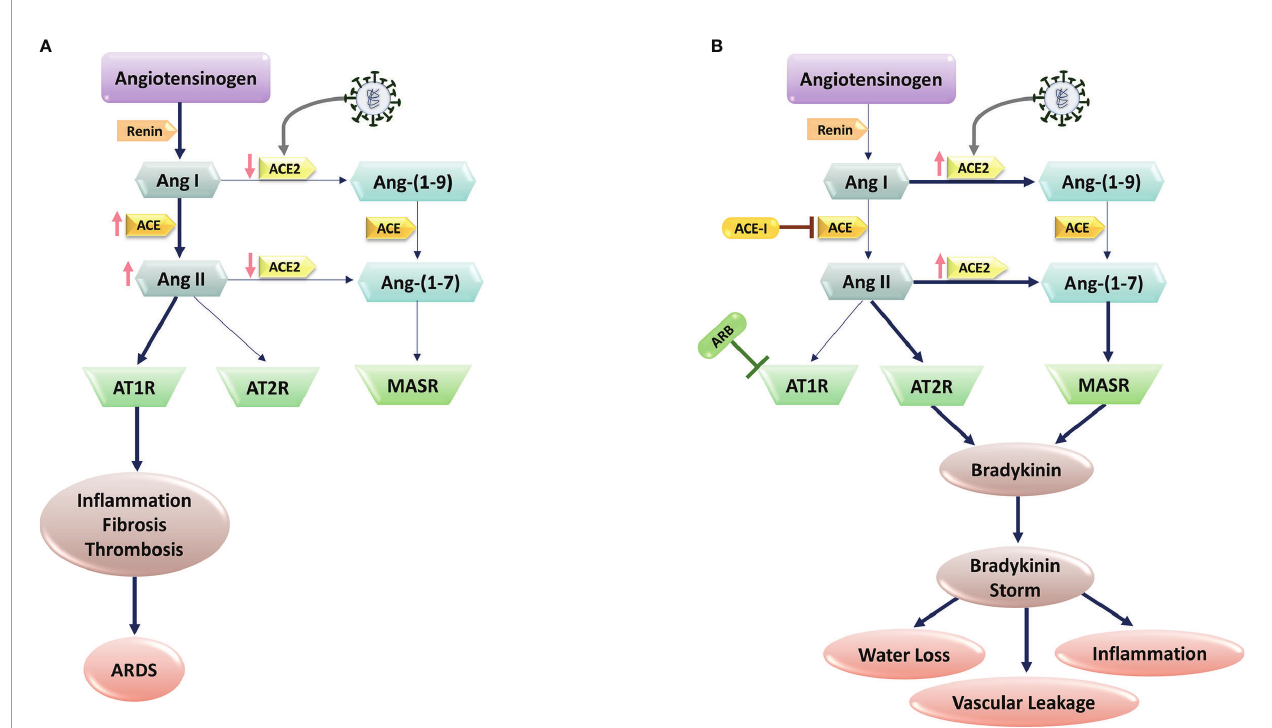
FIGURE 1 | SARS-CoV-2 and Renin-Angiotensin System (RAS) interactions. (A) SARS-CoV-2 infection is mediated via the human Angiotensin-Converting Enzyme 2 (ACE2), which would cause ACE2 downregulation. Subsequent block of Ang II/Ang – (1-7) metabolism lead to the high levels of Ang II production through ACE upregulation. The imbalanced Ang II/Ang 1 – 7 causes the suppression of AT2 and Mas receptors with anti-in fl ammatory properties. In contrast, Ang II and its receptor AT1R activations induce pro-in fl ammatory effects, fi brosis, and thrombosis, leading to Acute Respiratory Distress Syndrome (ARDS) in lungs. (B) In patients with comorbidities, including hypertension, administration of RAS blockers (e.g., ACE-I, and ARBs) suppresses the ACE pathway. In these patients, SARS-CoV-2 infection increase ACE2 expression. Upregulated ACE-2 converts Ang I to Ang – (1-9) and Ang – (1-7), activating the bradykinin pathway via MAS and AT2R receptors. Upregulated bradykinin (bradykinin storm) in the lungs of COVID-19 patients would increase SARS-CoV-2 virulence by inducing hypotension, vascular permeability, water loss, and in fl